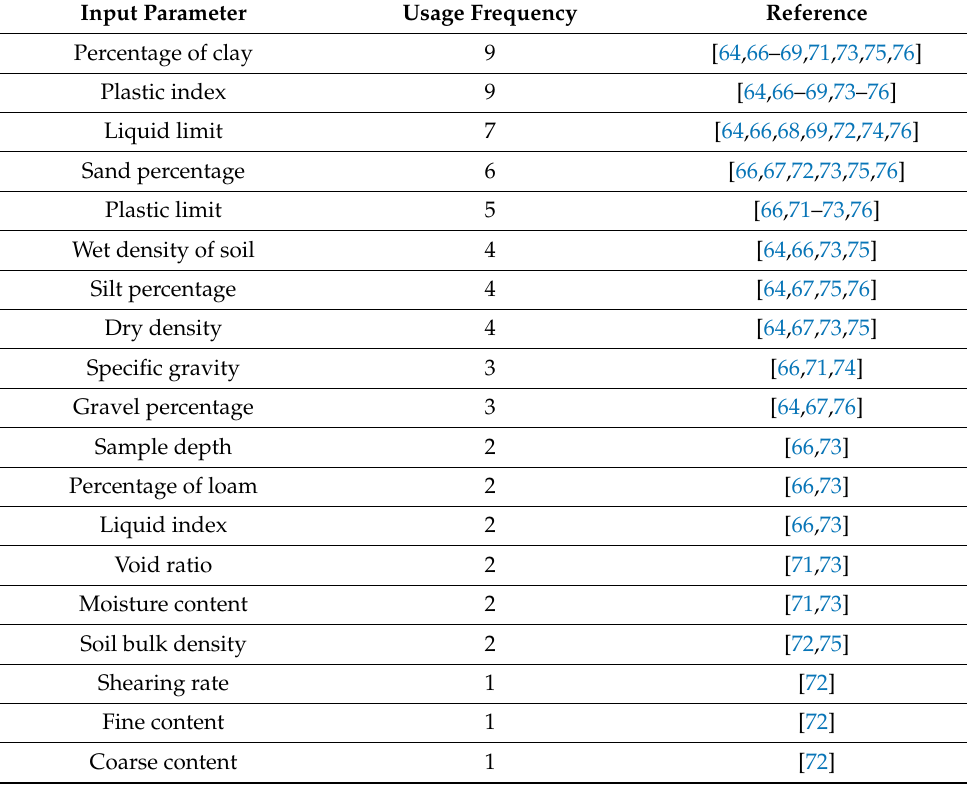
Table 5. List of commonly used input parameters for deciding the strength of a